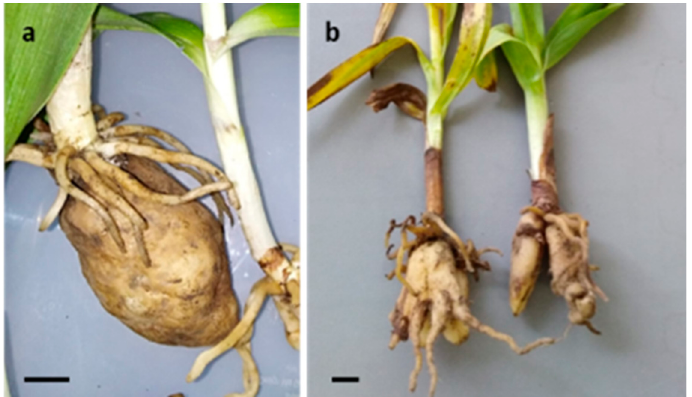
Figure 2. Bar = 1cm. ( a ) The large tuber of the giant orchid ( Himantoglossum robertianum ); ( b ) palmate tubers from Dactylorhiza sambucina. tubers from Dactylorhiza sambucina